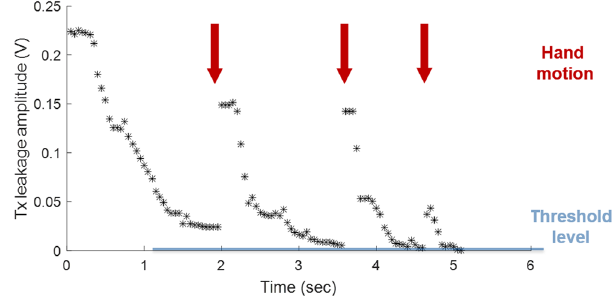
Figure 5. Voltage level of the residual Tx-induced leakage signal during automated feedback cancellation. Arrows show the instants when the hand position was changed and re-iteration was